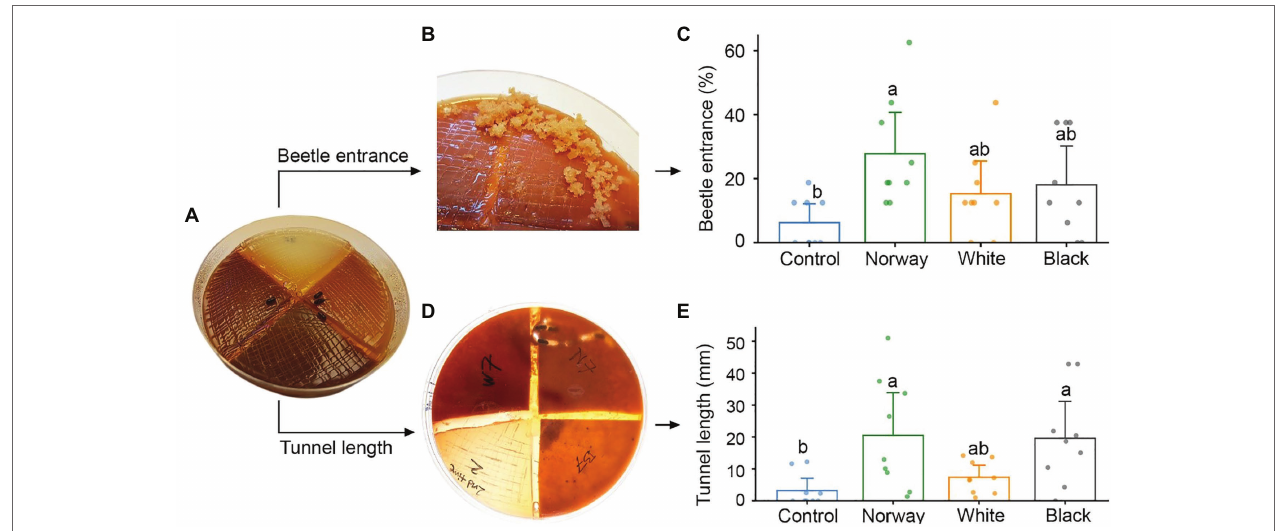
FIGURE 1 | Testing adult Ips typographus host preferences in multi-species choice arenas with a quadrant of water agar medium (control) and quadrants of spruce bark agar medium made from Norway spruce, white spruce, and black spruce. (A) Four beetles were released in each arena. (B,C) The number of beetles entering different media was registered after 18 h. (D,E) Beetle tunneling length in different media was measured after 5 days. Bars show mean values with 95% CIs. Dots represent individual replicates ( n = 9 individual trees per spruce species). Treatments with different letters (a, b) differed significantly (ANOVA with Tukey’s post hoc